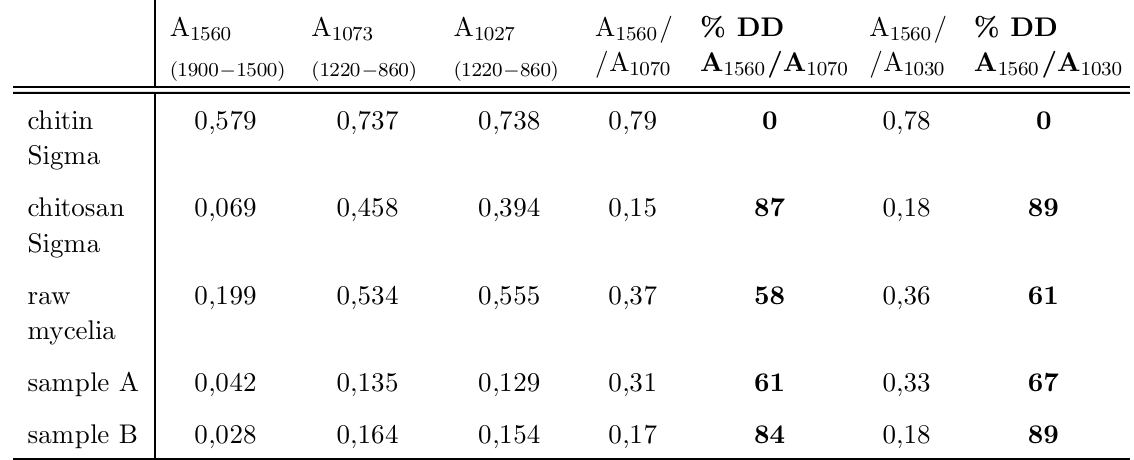
Table 1 Determination of the deacetylation degree (the baselines are listed in